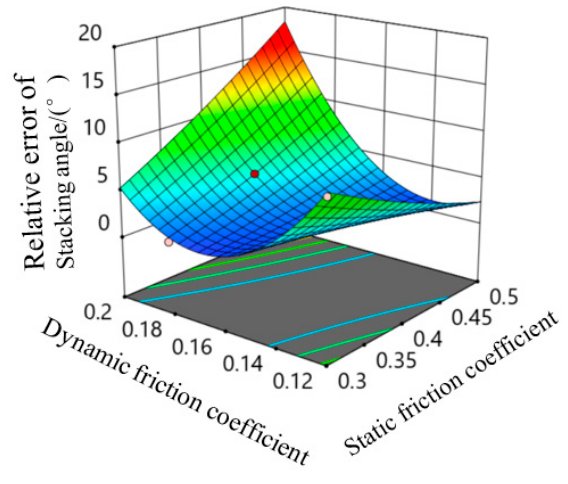
Figure 12. Response surface of lily bulb stacking angle.